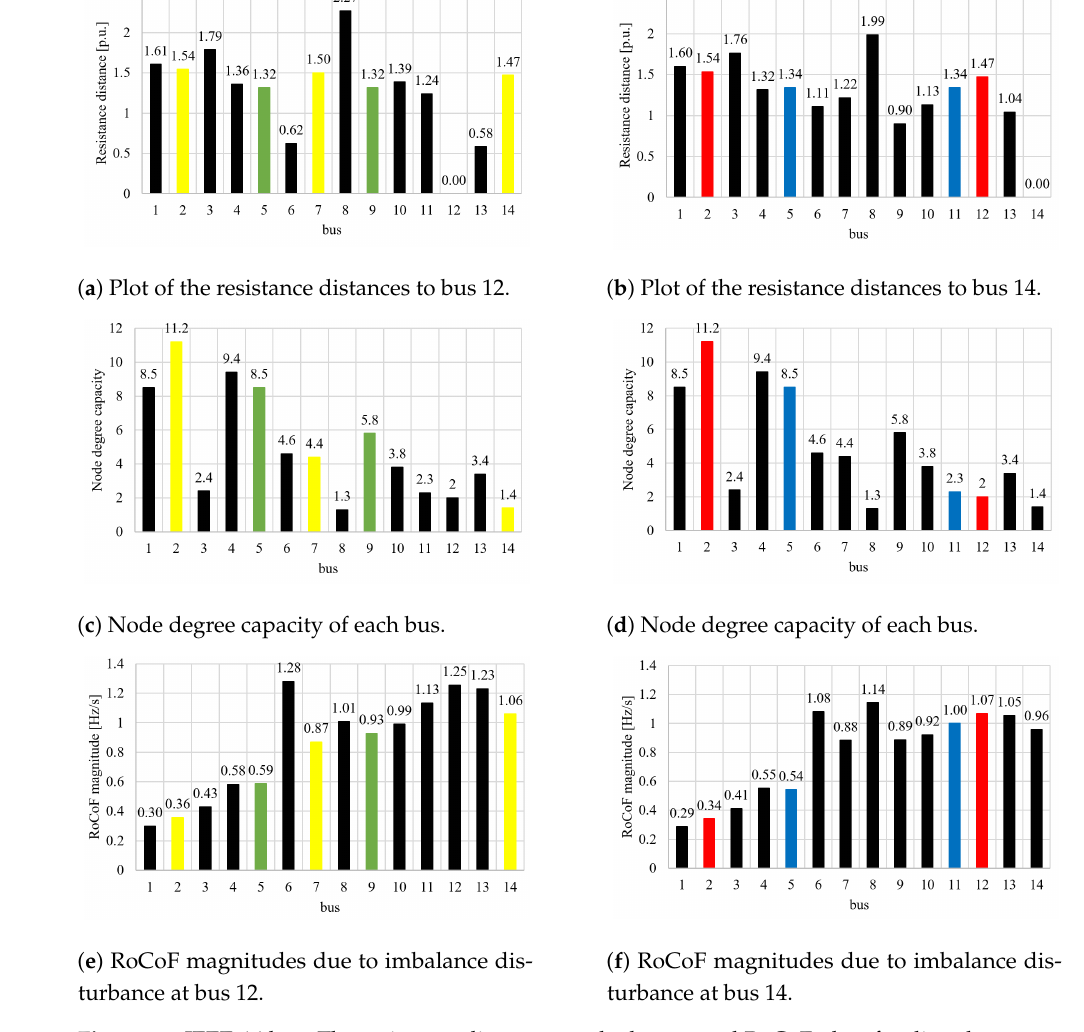
Figure 11. IEEE-14 bus: The resistance distances, node degree, and RoCoF plots for disturbances at bus 12 (left-side) and bus 14 (right-side),